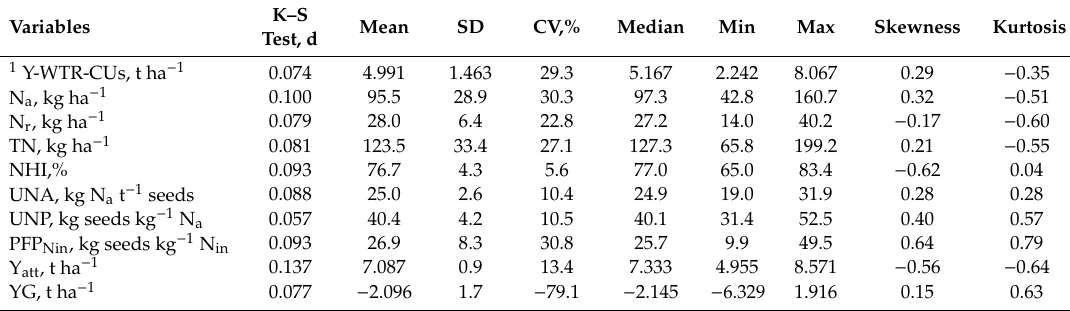
Table 7. Descriptive statistics of triticale yield characteristics and indicators of nitrogen